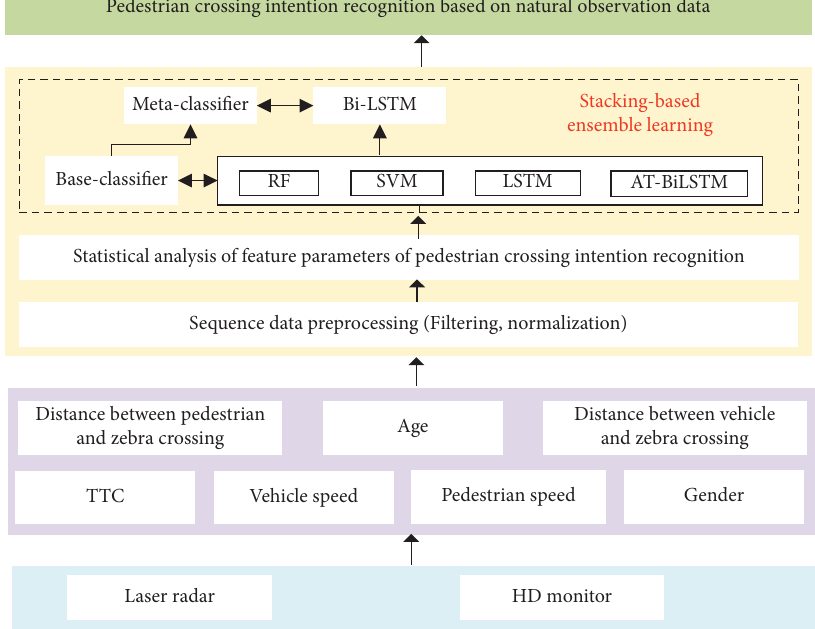
Figure 1: Research framework of pedestrian crossing intention: laser radar and HD monitor acquire data before pedestrians cross the zebra crossing. After the data are fltered, the characterization parameters of pedestrians’ crossing intention are obtained. After preprocessing, the characterization parameters are input into the stacking learning algorithm, and then the pedestrian crossing intention recognition model is